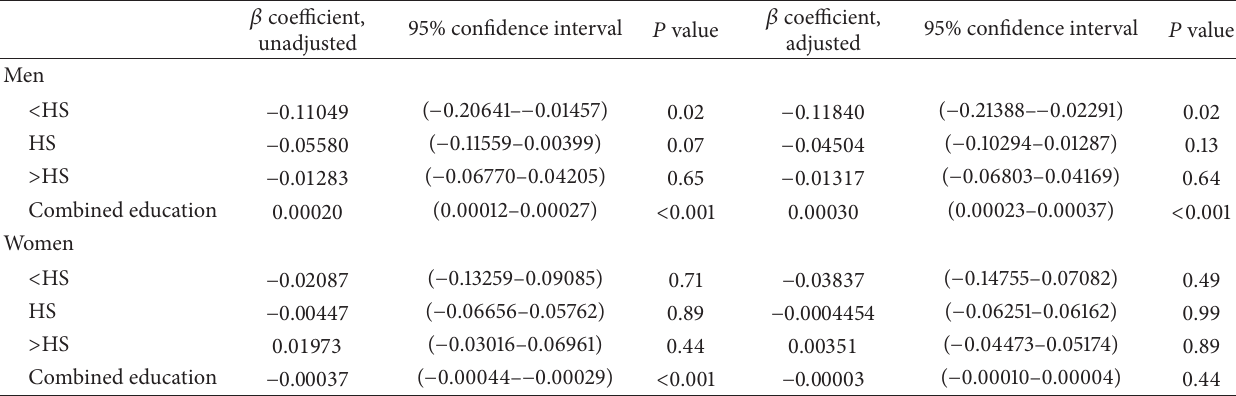
Table 2: Slope differences for BMI and survey year between Blacks compared to Whites among men and women, overall and by educational attainment, 1997–2008.